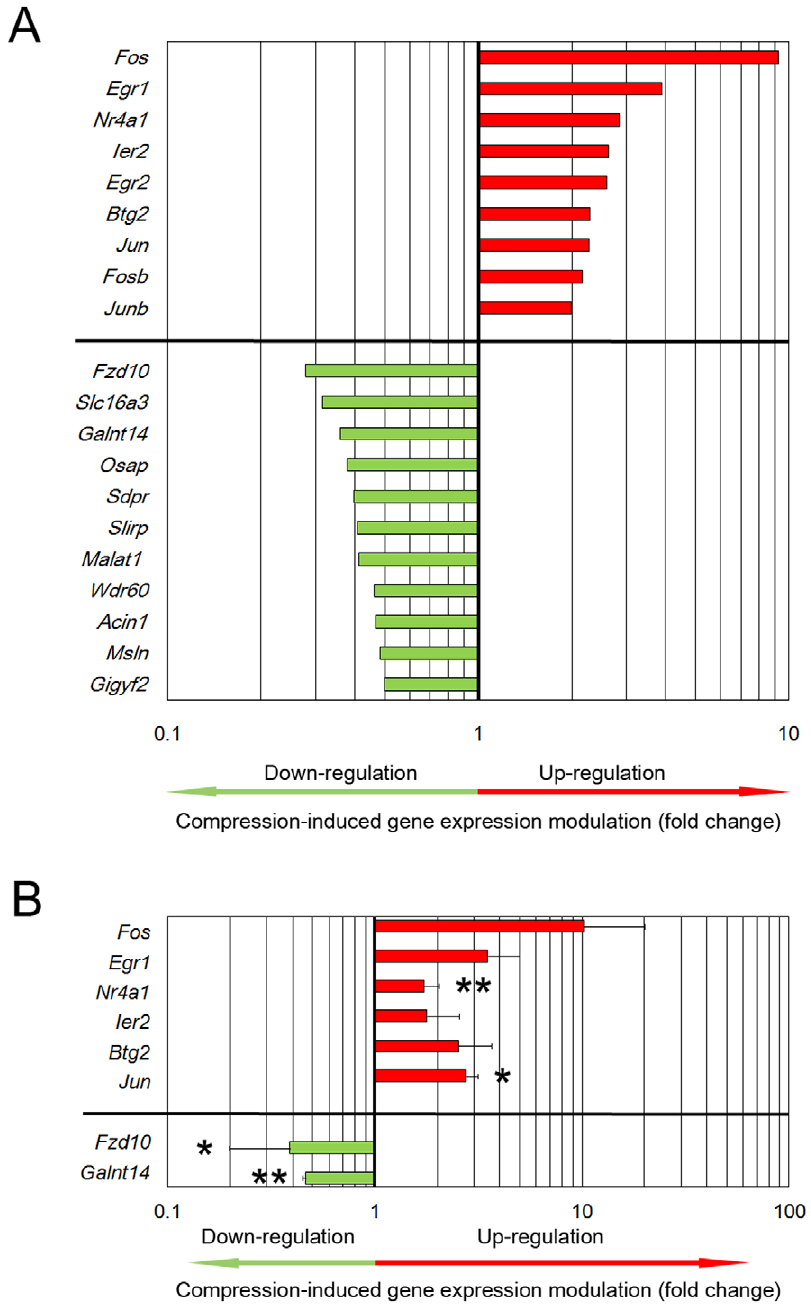
Figure 4. Identification of major candidate mechanosensitive genes. Gene expression levels of compressed samples were compared to uncompressed controls. (A) DNA microarray analysis was performed on four independent pairs of uncompressed/compressed experiments. Expression level differences were sorted to identify highly responsive genes (fold change . 2), resulting in a list of 20 transcripts. Bars represent the fold change in gene expression upon compression, i.e. up-regulation (red) or down-regulation (green) (p , 0.01). Exact modulation factors and associated p-values are detailed in Table 1. (B) Real-time PCR analysis on three independent experiments confirmed DNA microarray results for eight selected genes. Bars represent the compression-induced gene expression modulation (mean + / 2 SD), either up-regulation (red) or down-regulation (green) (* p , 0.05, ** p , 0.01).